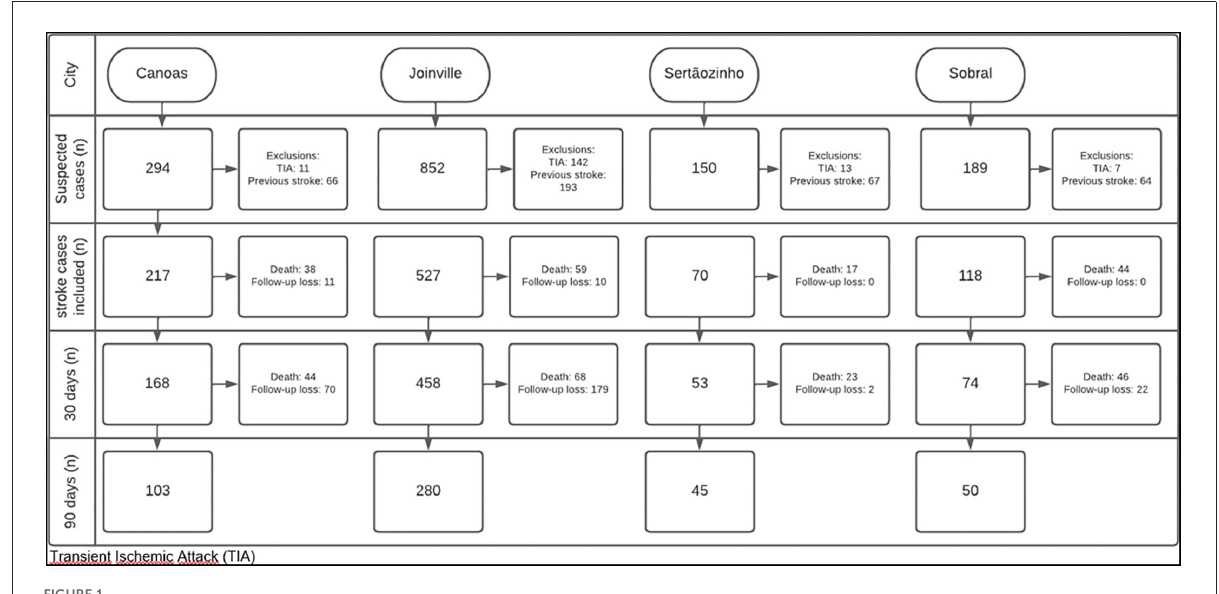
FIGURE1 Flowchart of the study